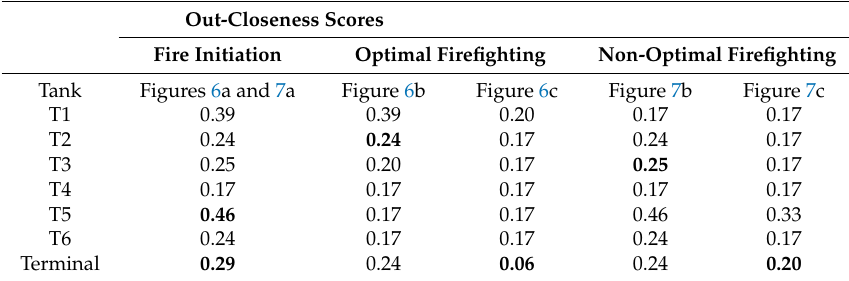
Table 3. Tanks’ and terminal’s out-closeness scores for the graphs in Figures 6 and